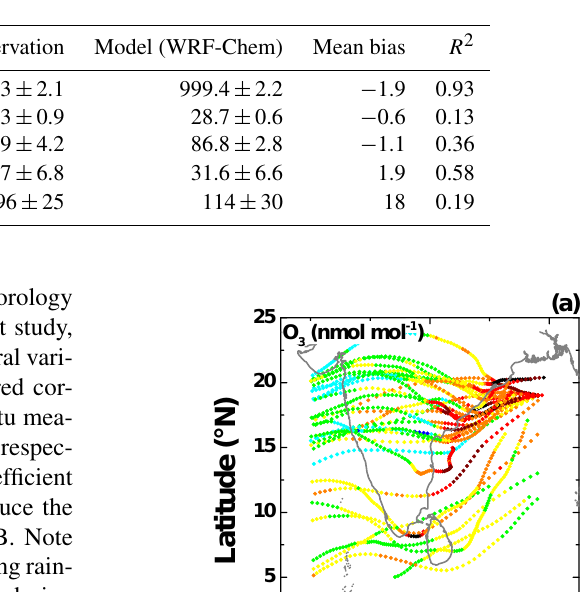
Table 3. A comparison of mean values from observations with model-simulated parameters along with the mean bias. The squared correlation coefficients correspond to the linear regression analysis between daily averaged in situ and simulated parameters.